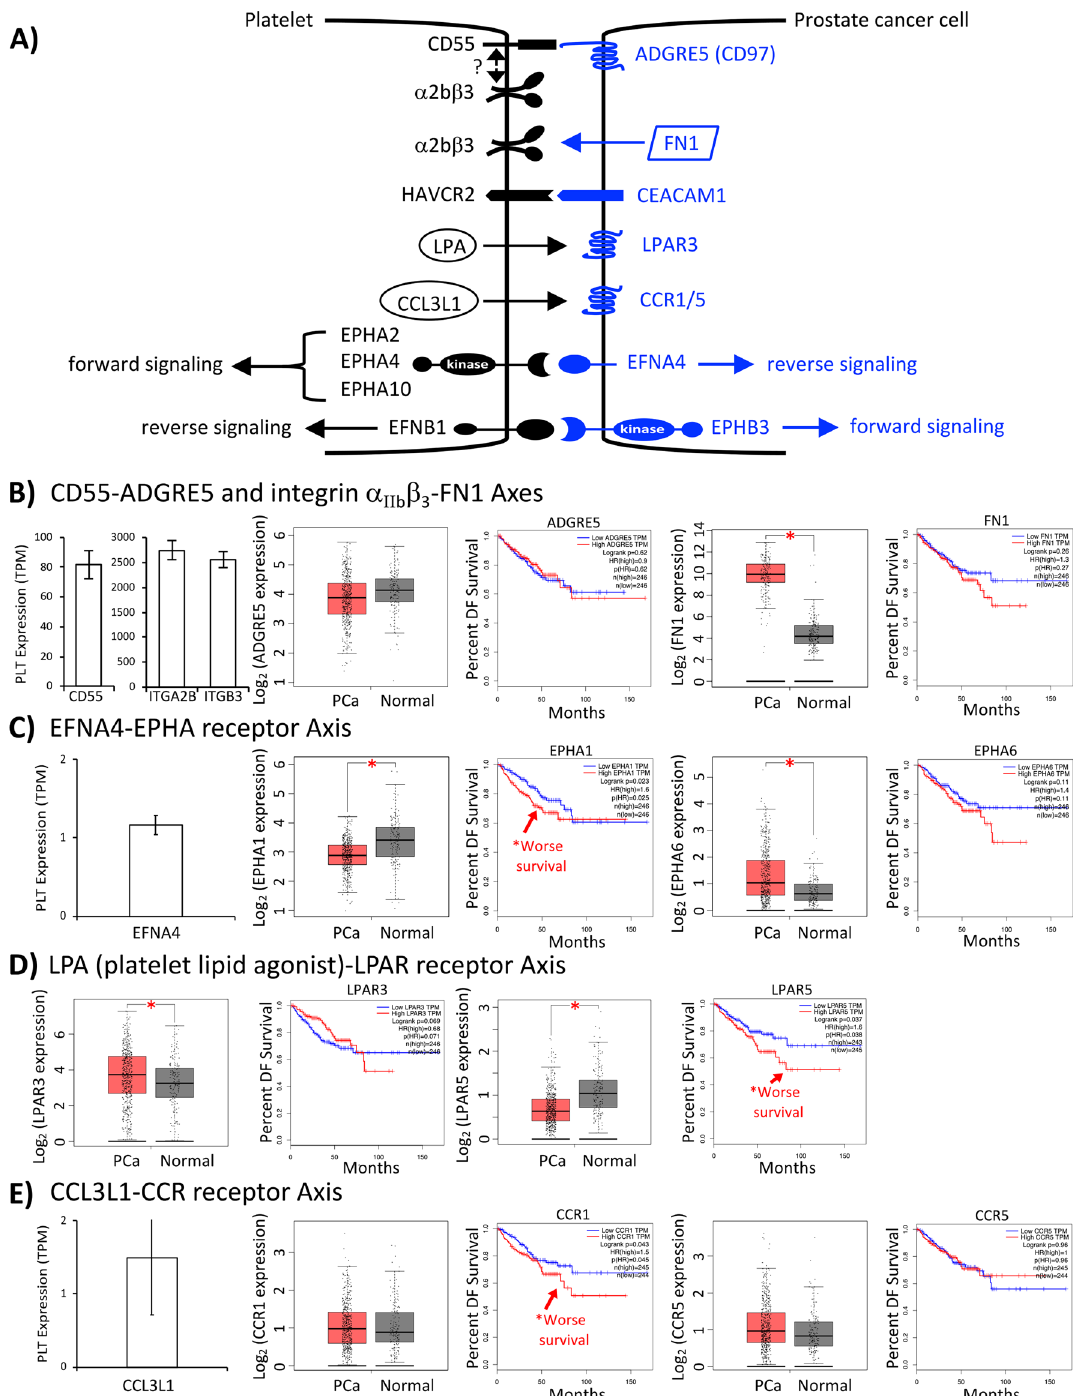
Figure 4. Candidate PCa cell-platelet signaling axis partners. ( A ) Schematic representation of potential signaling axes mediating PCa cell-platelet interactions. ( B – E ) Bar graphs depict expression of platelet signaling partner and corresponding PCa signaling partner based on Garofano et al. 24 and TCGA RNA-Seq data. Disease free (DF) survival plots are depicted for PCa signaling partners based on TCGA data. Signaling axes (platelet component-PCa component) displayed include ( B ) CD55-ADGRE5 and α IIb β 3 -FN1, ( C ) EFNA4-EPHA receptor, ( D ) LPA-LPAR receptor, and ( E ) CCL3L1-CCR receptor. TPM, transcript per million; *, Student’s t -test or logrank test, * P <